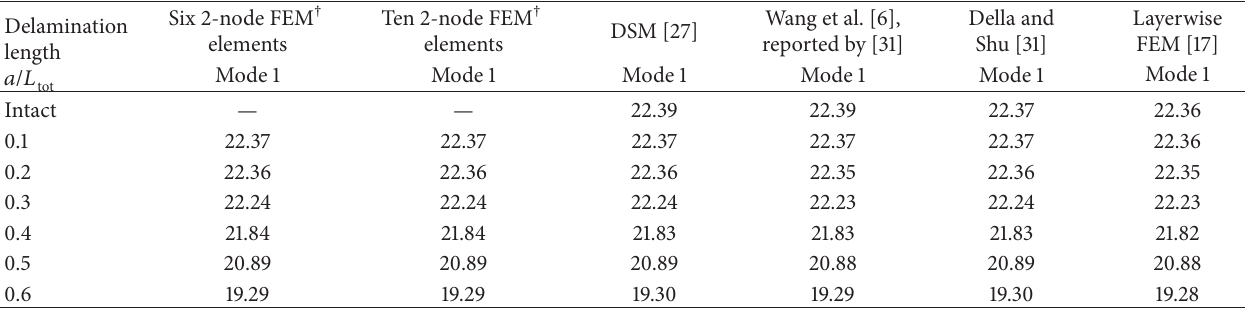
Table 1: First frequency ( 𝜆 2 ) of the delaminated beam, with a split occurring symmetrically about the midsection along the midplane; proposed FEM, DSM, CM, and standard FEM models.